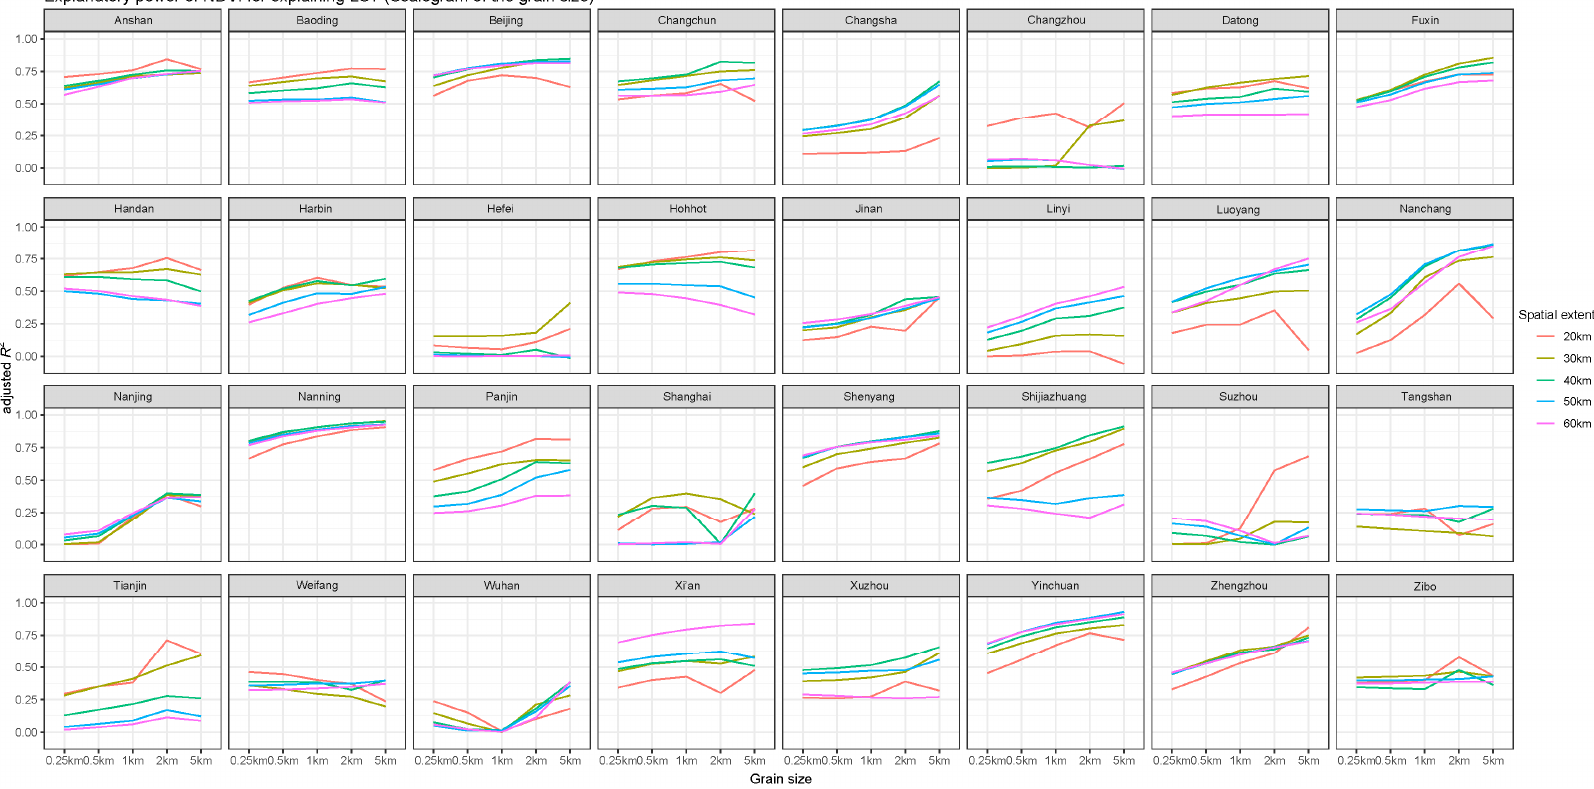
Figure A5. Explanatory power of NDVI for explaning LST(Scalogram of the grain size).